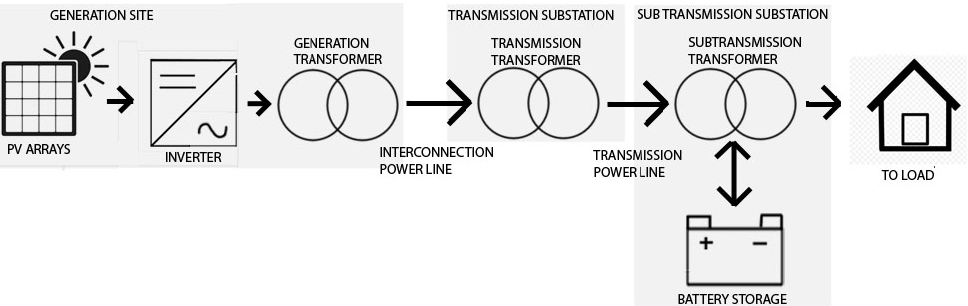
Figure 1. Electric pathway considered. Battery energy storage is assumed to have the necessary power conditioning units. The battery system interconnection line is assumed to have negligible costs and efficiency losses.